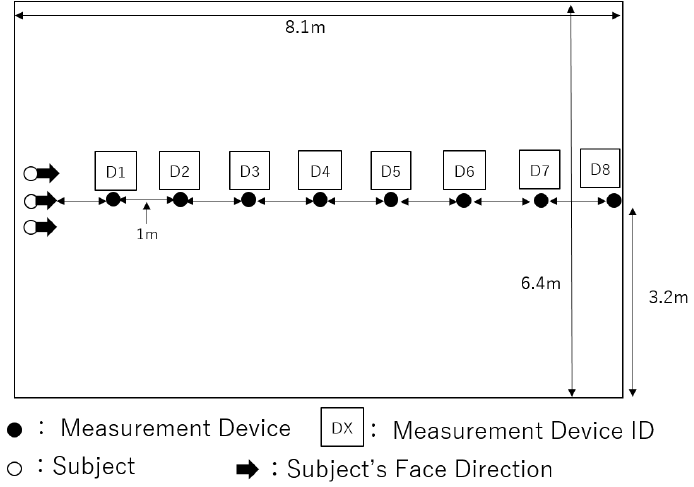
Figure 3. Position of subjects and measurement devices in Case